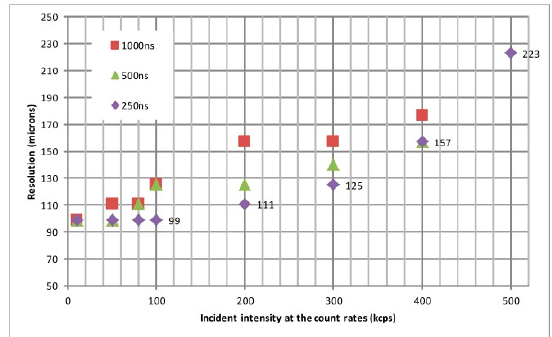
Figure 17. The image resolution plot versus incident photon counting rate with different peaking times of the pulse shaper. The resolution value that can be achieved by the system applies a fixed scale from the 1951 USAF resolution mask. For a specific peaking time of the pulse shaper, the resolution will decrease rapidly with a massive increase in incident intensity.